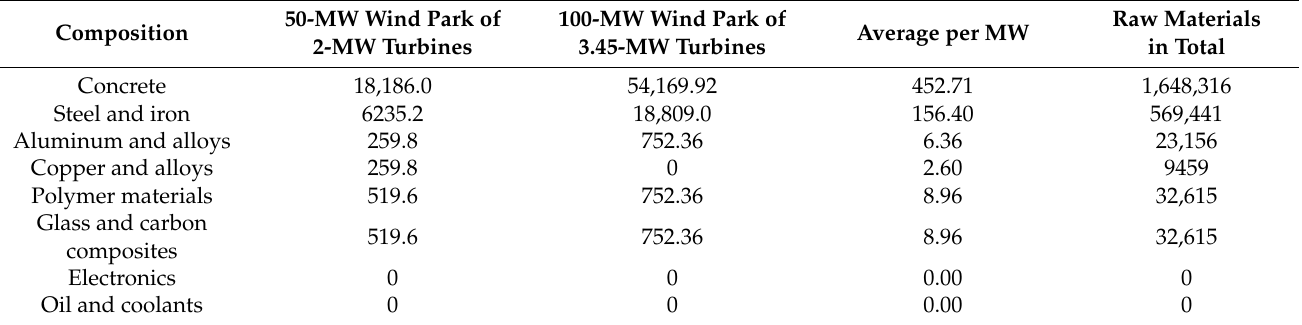
Table 3. Compositions of raw materials (in tons) in wind power plants that should be decommissioned in Ukraine in from 2044 to